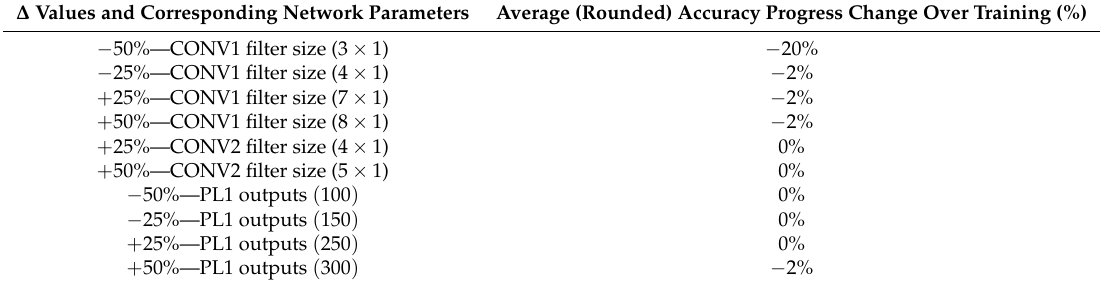
Table 2. Net parameterization results obtained from PARMOD tests—the average training change for all the three subjects from the examined